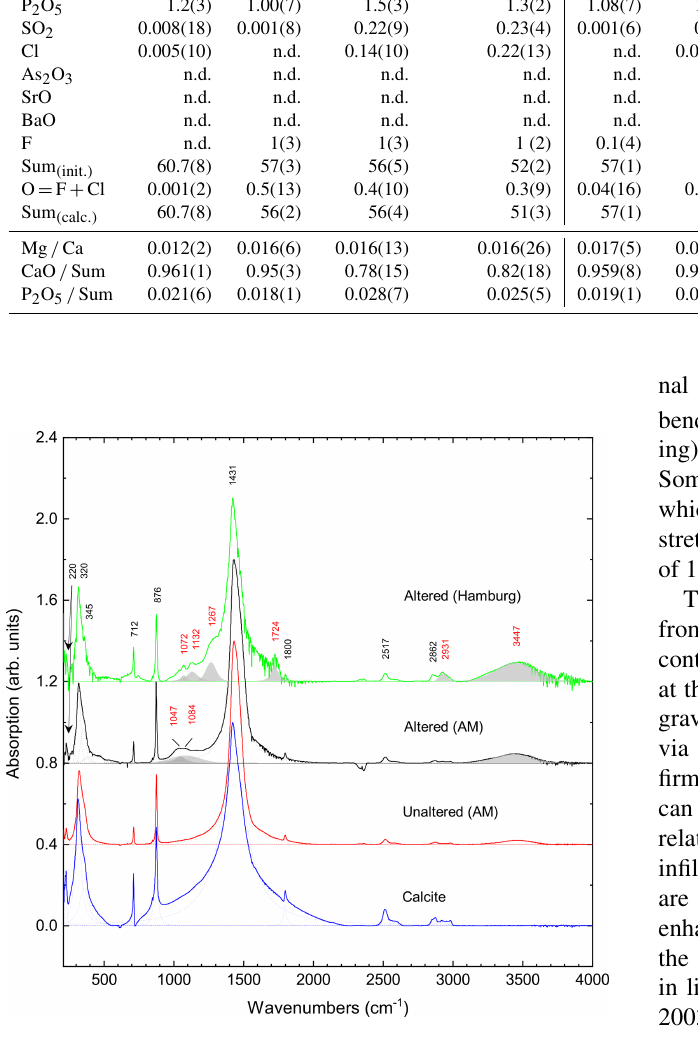
Figure 6. Infrared absorption spectra of altered areas of marbles from Ohlsdorf and Asia Minor (sample MaB1A and AM_C1, re- spectively), as well as of unaltered areas of the sample AM_C1, along with a reference calcite spectrum. Peak positions typical of calcite are marked in black, whilst the positions of extra peaks in the spectra from altered marble are given in red. The spectra were vertically offset for